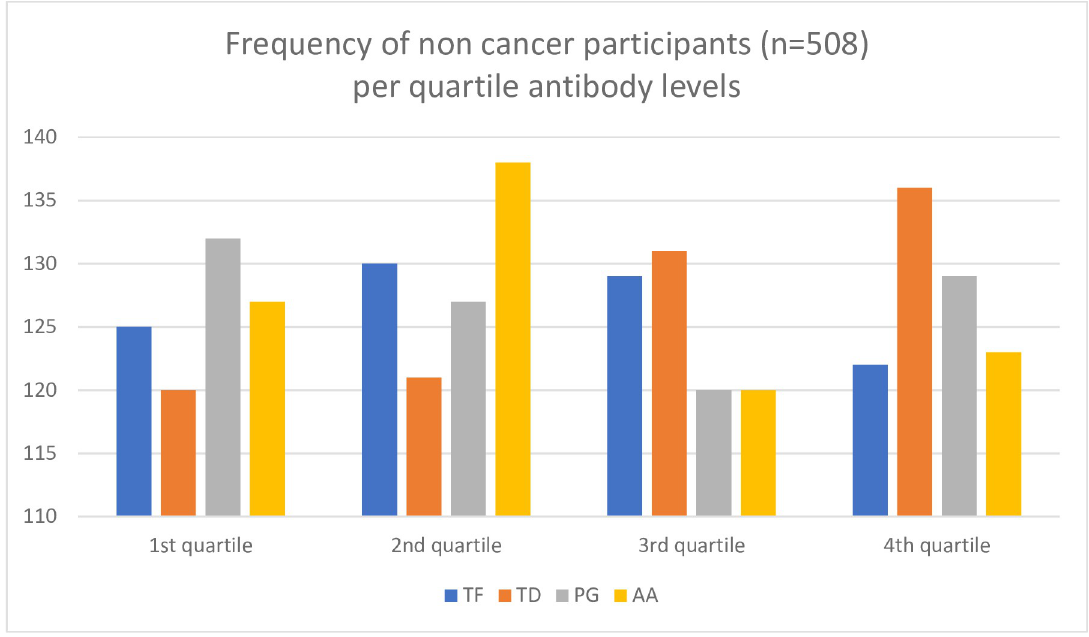
Fig 4. Frequency of non-cancer participants (n = 508) per quartile antibody levels of the oral bacteria Tannerella forsythia (TF), Porphyromonas gingivalis (PG), Treponema denticola (TD), and Aggregatibacter actinomycetemcomitans (AA). Quartile (Q) levels: TF Q1 1–28, Q2 29–44, Q3 45–73, Q4 74–1240, TD Q1 1–28, Q2 29–44, Q3 45–73, Q4 74–1240, PG Q1 1–28, Q2 29–44, Q3 45–73, Q4 74–1240., AA Q1 1–28, Q2 29–44, Q3 45–73, Q4 74–1240.